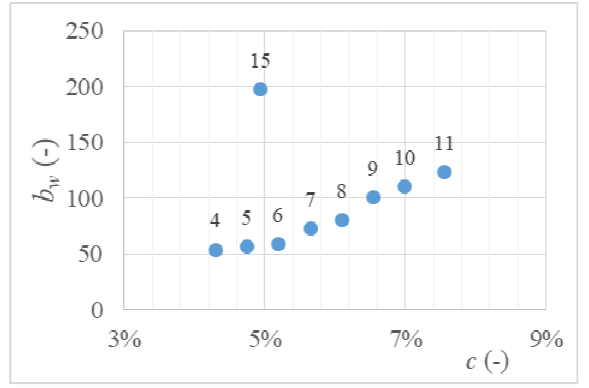
Fig. 7. Optimized boundary of white dependent on concentration .